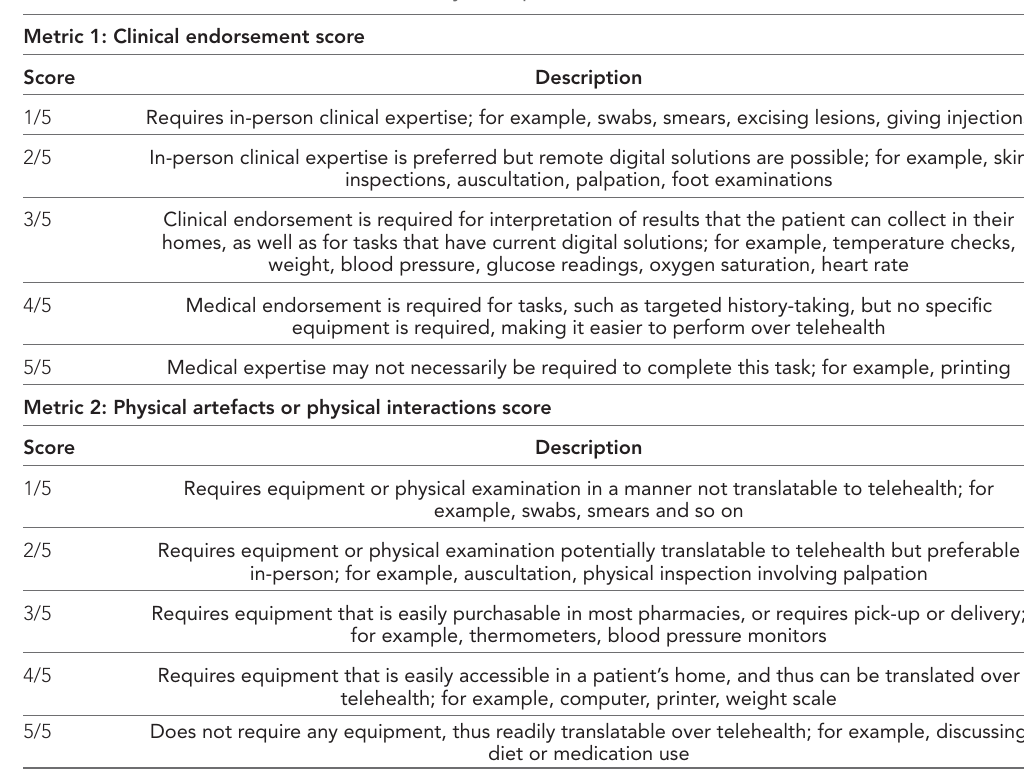
Table 1 Metrics used to score translatability of in- person tasks Metric 1: Clinical endorsement